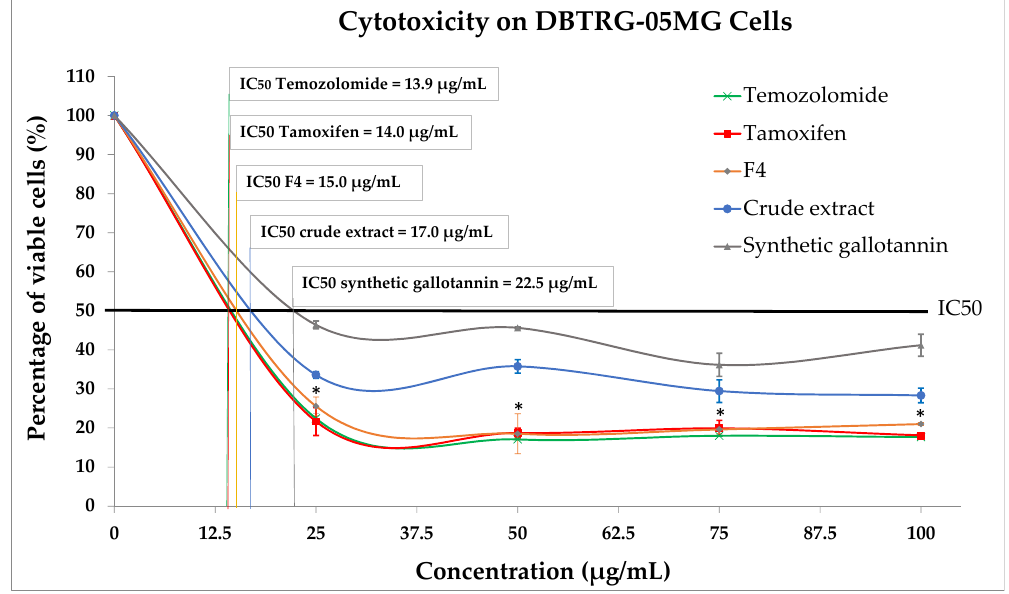
Figure 8. Cytotoxicity on human GBM cell line (DBTRG-05MG) after treatment with F4, crude extract, synthetic gallotannin and clinical cancer drugs (Temozolomide and Tamoxifen). IC 50 = half maximal inhibitory concentration (* p < 0.05 for F4 vs. crude extract and synthetic gallotannin).